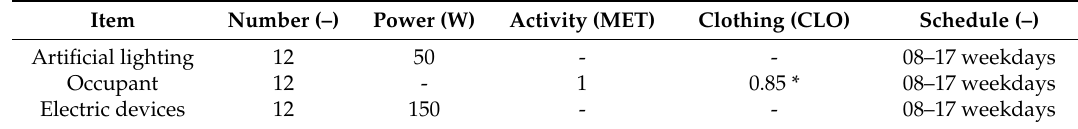
Table 3. Elements causing cooling loads in the room (used in